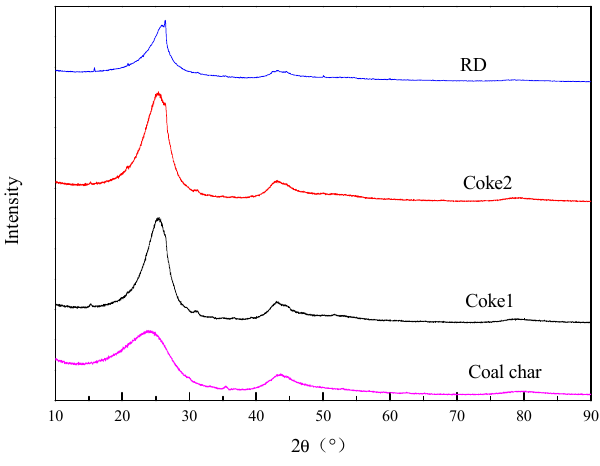
Figure 4. X-ray diffraction (XRD) spectra of RD, C-1, C-2 and CC.